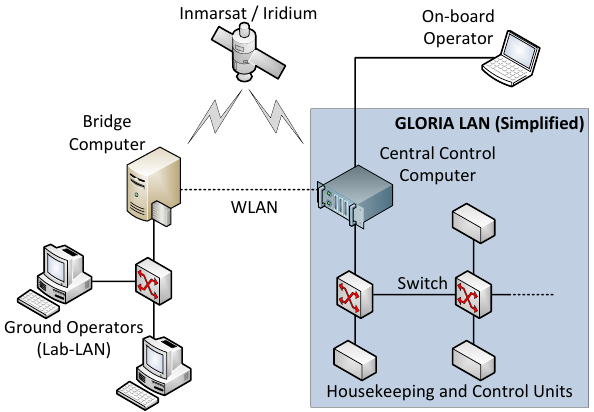
Figure 1. Overview of the network topology. On the left side, the ground infrastructure communicates with the on-board infrastruc- ture, shown on the right side, through satellite up- and downlink or through WLAN.